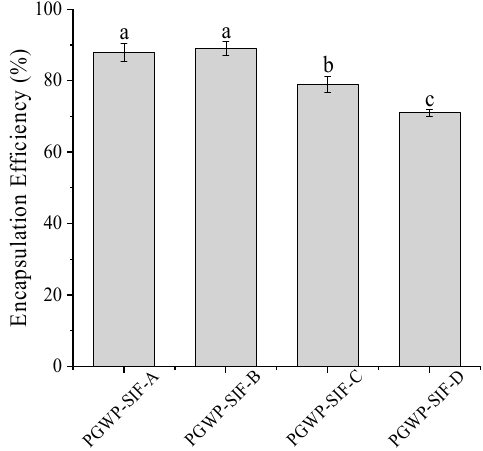
Figure 1. Effect of the soy isoflavone (SIF) contents on encapsulation efficiency of polymerized goat Figure 1. E ff ect of the soy isoflavone (SIF) contents on encapsulation e ffi ciency of polymerized goat milk whey protein (PGWP)-SIF. Different subscript letters indicate a significant difference ( P < 0.05). milk whey protein (PGWP)-SIF. Di ff erent subscript letters indicate a significant di ff erence ( P < 0.05). Error bars represent standard deviation of the means. Error bars represent standard deviation of the